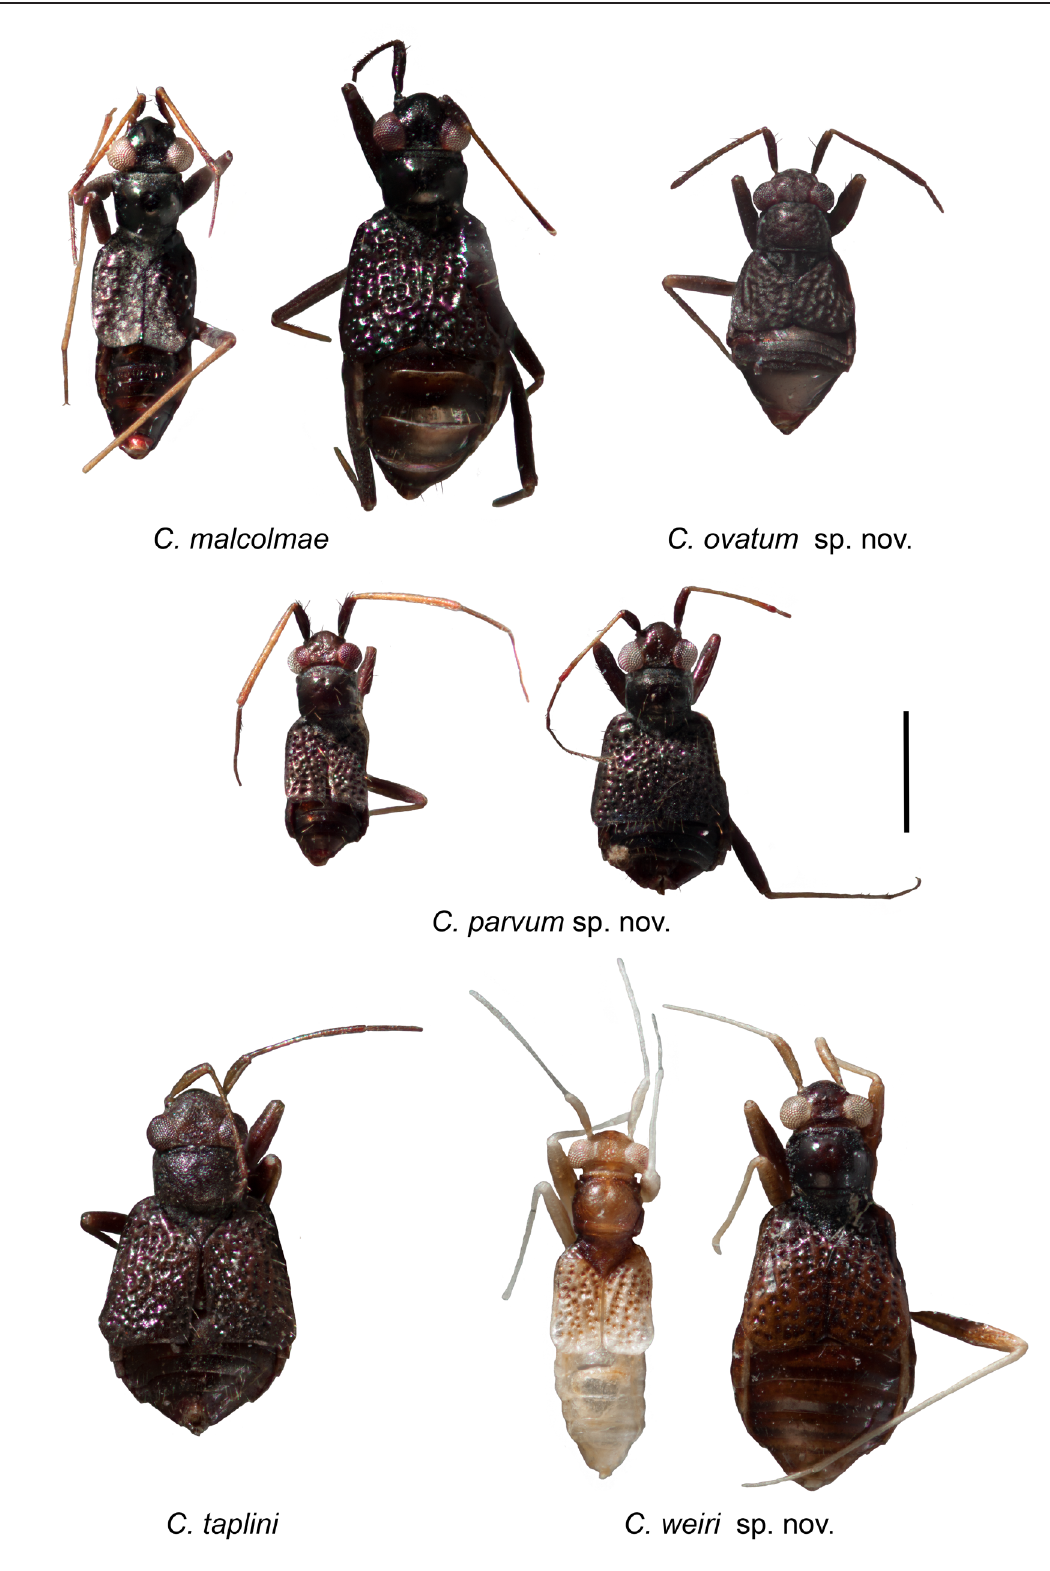
Fig. 1. Habitus of Carvalhoma species. Scale bar = 1 mm. When two specimens of the same species are shown, the male is on the left and the female on the right. C. ovatum sp. nov. shows the male holotype. C. taplini Slater & Gross, 1977 shows the